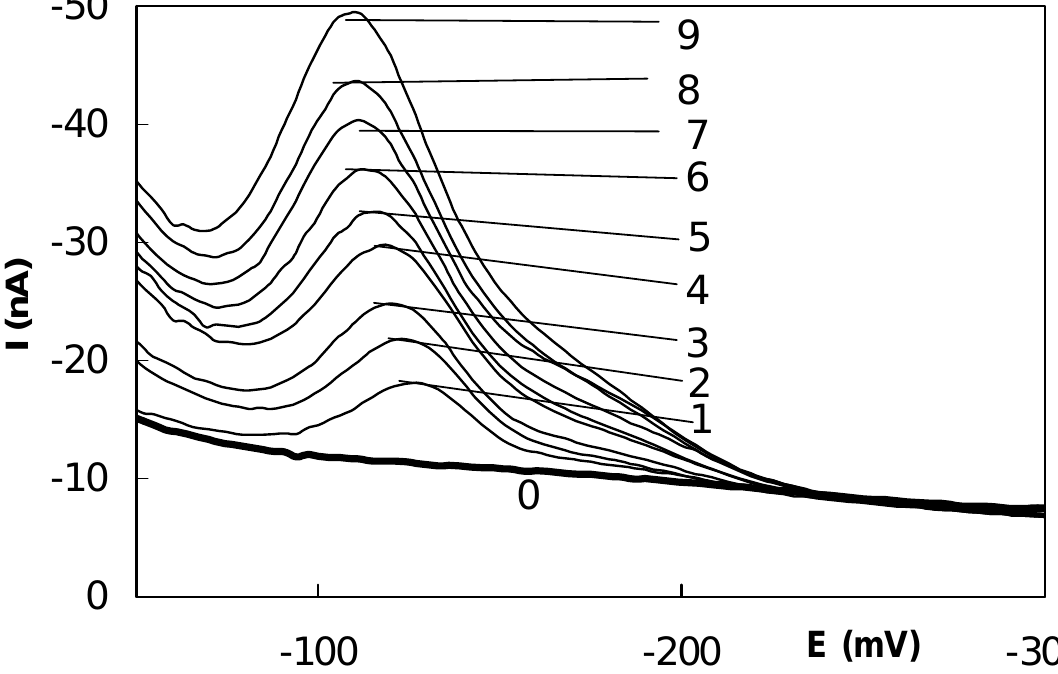
Figure 2. Differential pulse voltammograms of N,N-dimethyl-4-amino-2´-carboxy-azobenzene at m- AgSAE in a Britton-Robinson buffer, pH 5.0, c [ µ mol.l -1 ]: (0) base electrolyte, (1) 1.9, (2) 3.8, (3) 5.6, (4) 7.4, (5) 9.0, (6) 10.7, (7) 12.2, (8) 13.7, (9)